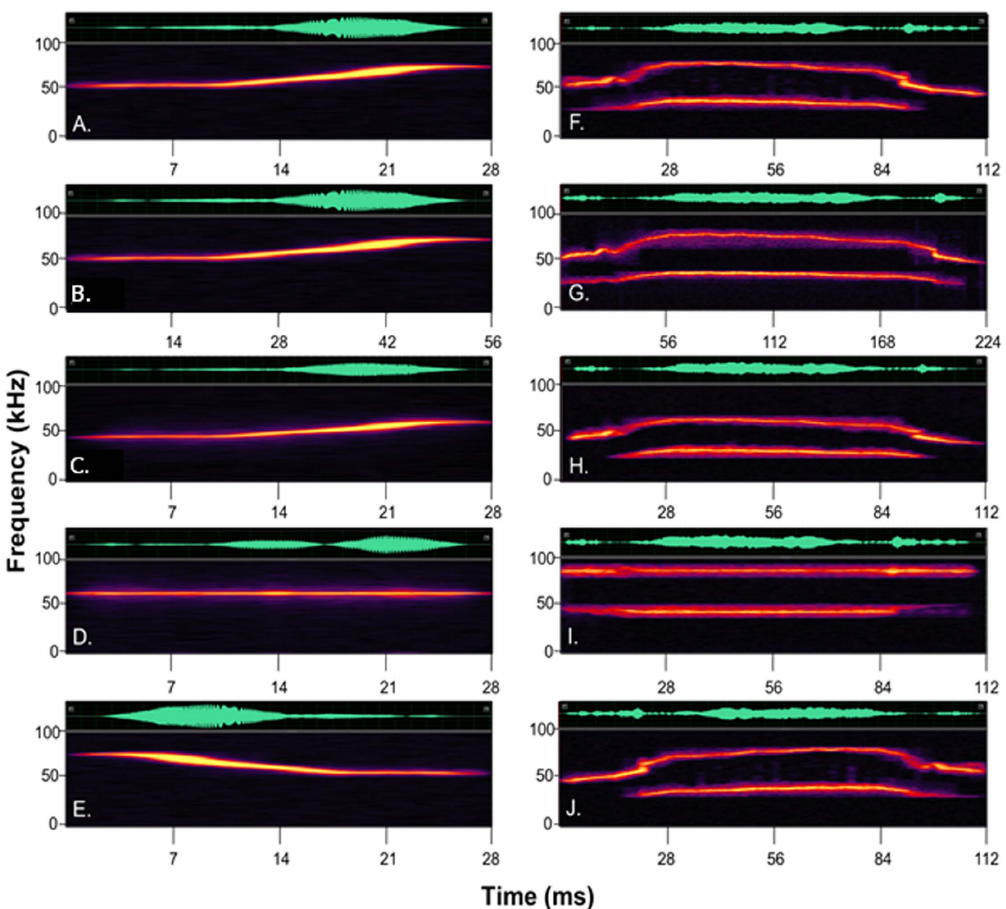
Figure 1. Vocalization spectrograms. Spectrograms of two unmodified vocalizations (A=Male Upsweep and F=40 kHz Harm/2 Jump), and those same two vocalizations doubled in duration (B and G), lowered in frequency by 20% (C and H), with frequency modulation removed (D and I), and reversed in time (E and J).